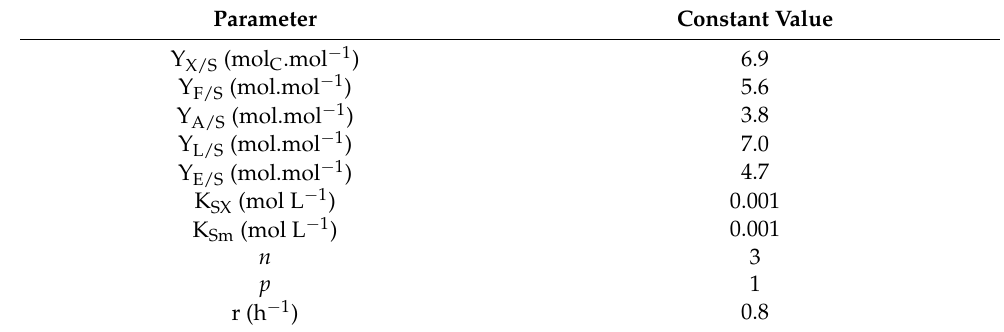
Table 1. Model parameters independent of operating conditions, determined from the experimental data of experiment F10 (T = 30 ◦ C, pH = 8) with t lag = 10 h.